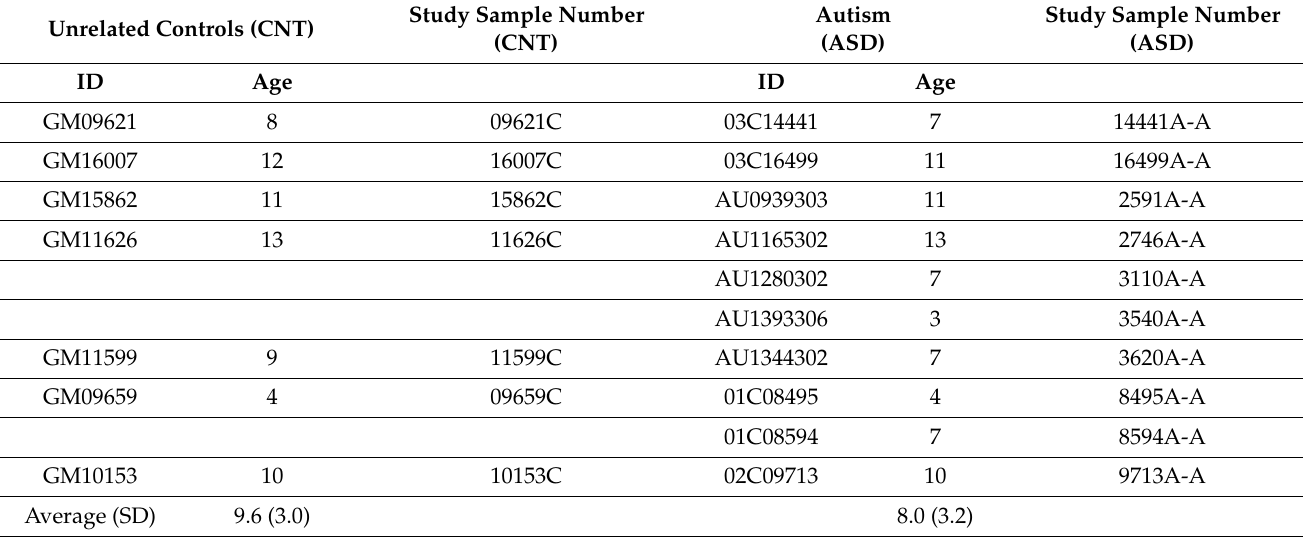
Table 1. Lymphoblastoid Cell Lines (LCLs) used in this study from children with autistic disorder and age- and gender-matched control LCLs. Average age of each group is